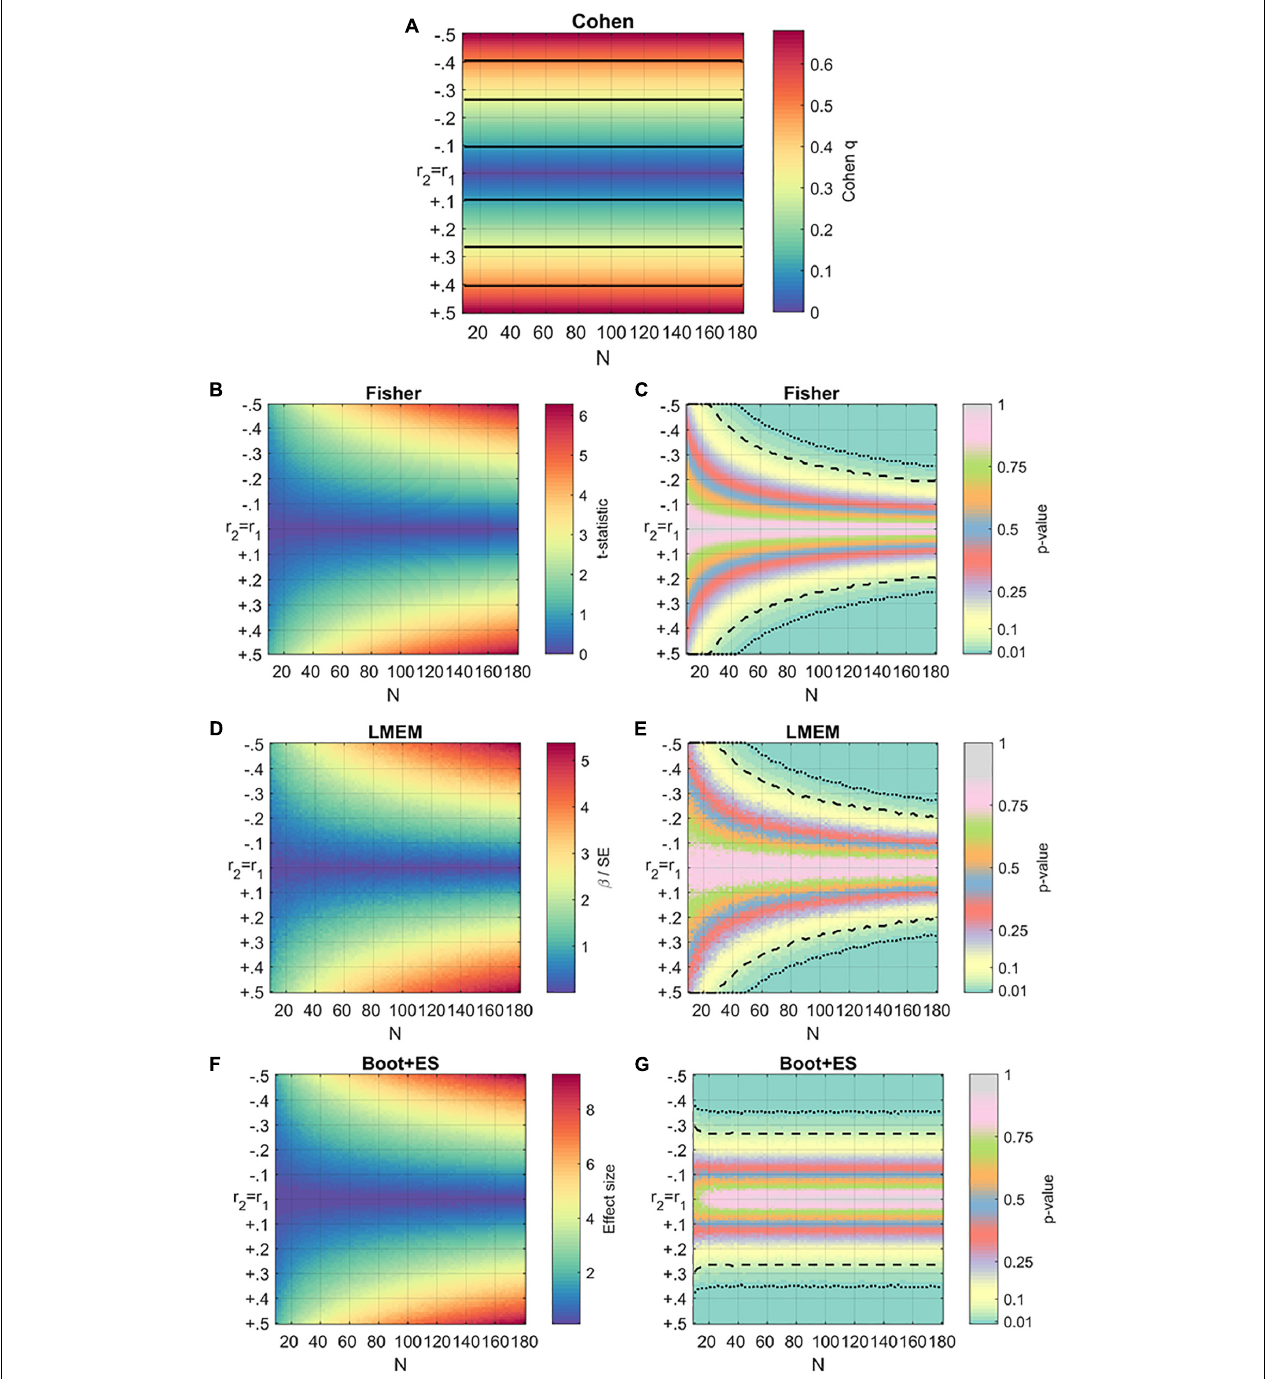
FIGURE 1 | Results of the generalized simulations using the four methods. For all the subfigures, the horizontal axis represents the sample size, while the vertical axis represents values of r2 compared to r1. The third dimension (heat) represents the effect size or the p -value of each method (A) Results of the simulations using Cohen’s q. The effect sizes are averaged across values of r1. Black horizontal lines are used to separate the different levels of effect: small (blue), medium (cyan), large (green). (B,C) Results of the simulations using Fisher’s method. Statistics are averaged across values of r1. T -statistics are reported on the left panel, p -values on the right panel. Dashed and dotted lines represent thresholds of p < 0.05 and p < 0.01, respectively. (D,E) Results of the simulations using mixed-effect models (LMEM). Statistics are averaged across values of r1. β values for the interaction condition: covariate divided by their standard errors (SE) are reported on the left panel, corresponding p -values are reported on the right panel. (F,G) Results of the simulations using bootstrap (Boot + ES). Statistics are averaged across values of r1. Effect sizes (Cohens’ d) are reported on the left panel, corresponding p -values are reported on the right panel.